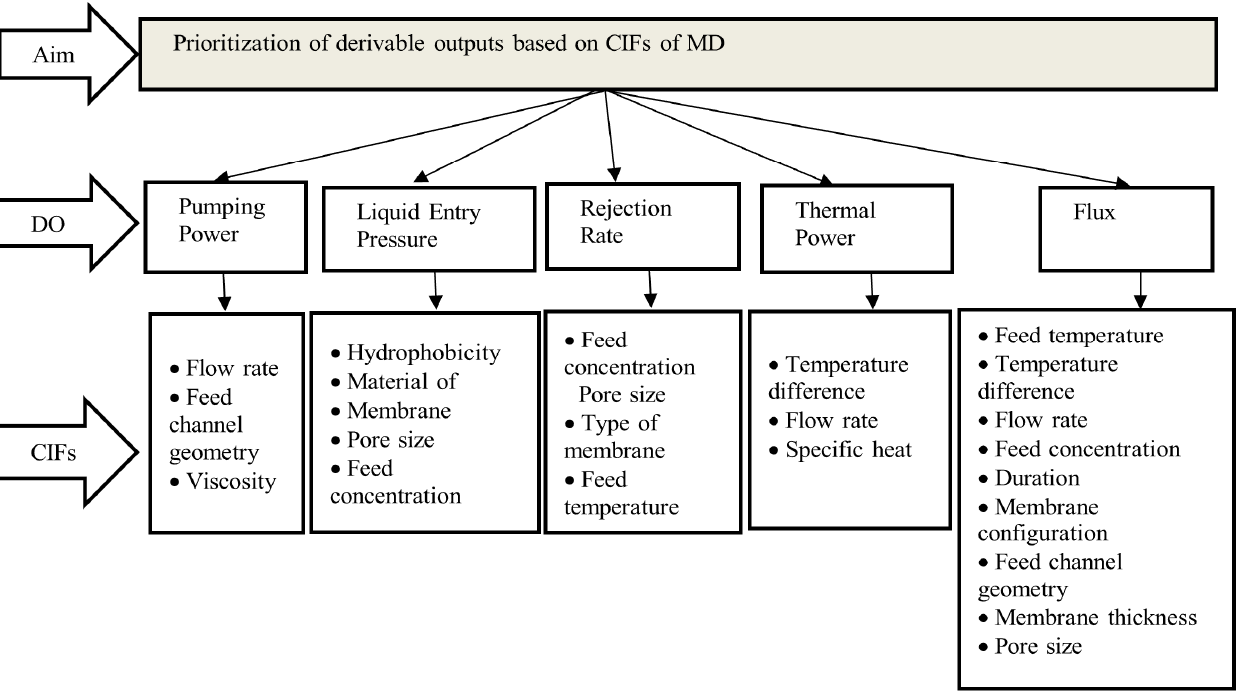
Figure 3. Multi-Criteria Decision-Making (MCDM) model for output-based analysis of MD.